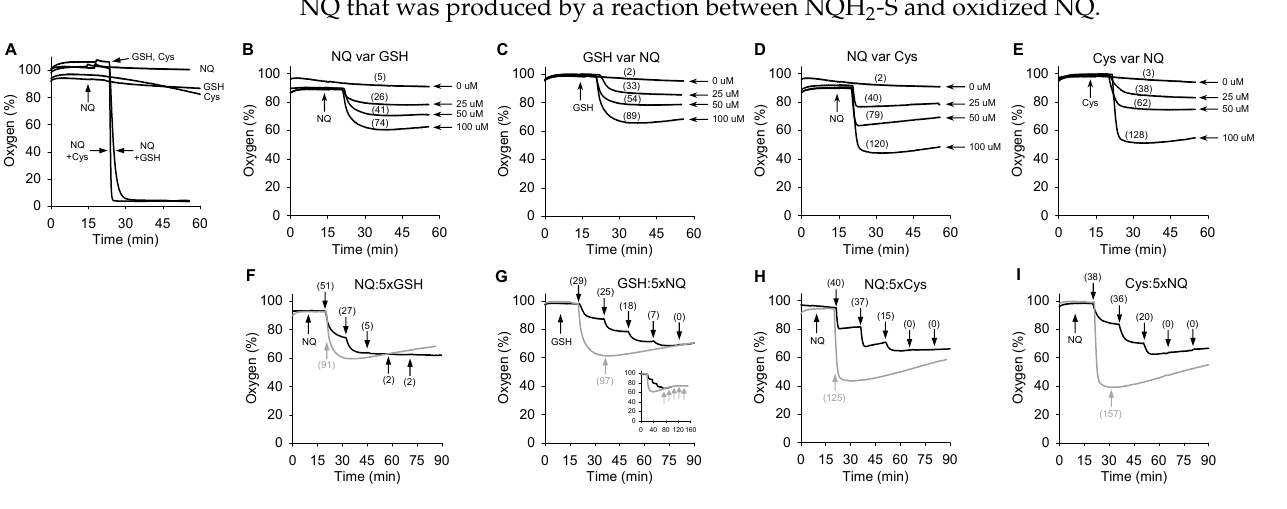
Figure 5. Oxygen consumption by mixtures of 1,4-NQ, GSH, and Cys. ( A ) Oxygen is rapidly consumed by 200 µ M of GSH or 280 µ M of Cys added to 4 mM 1,4-NQ (0.05:1 and 0.07:1 thiol:1,4-NQ, respectively), but neither thiol nor 1,4-NQ consumes oxygen alone. ( B – E ) Oxygen consumption by 100 µ M 1,4-NQ and increasing thiol concentrations ( B , D ) or by 100 µ M thiol with increasing 1,4-NQ concentrations ( C , E ). ( F , G ) Oxygen consumption following a single addition of 125 µ M (gray line and symbols) or five sequential additions of 25 µ M (black line and symbols) of GSH or Cys to 100 µ M 1,4-NQ (( F , H ), respectively), or single and sequential additions of 1,4-NQ to 100 µ M GSH or Cys (( G , I ), respectively). Expanded timescale in ( G ) (inset) shows the lack of effect of 5 additions of 25 µ M 1,4-NQ (gray arrows) to the single 125 µ M GSH-100 µ M 1,4-NQ sample. Values in parentheses show the net decrease in oxygen concentration in µ M for each